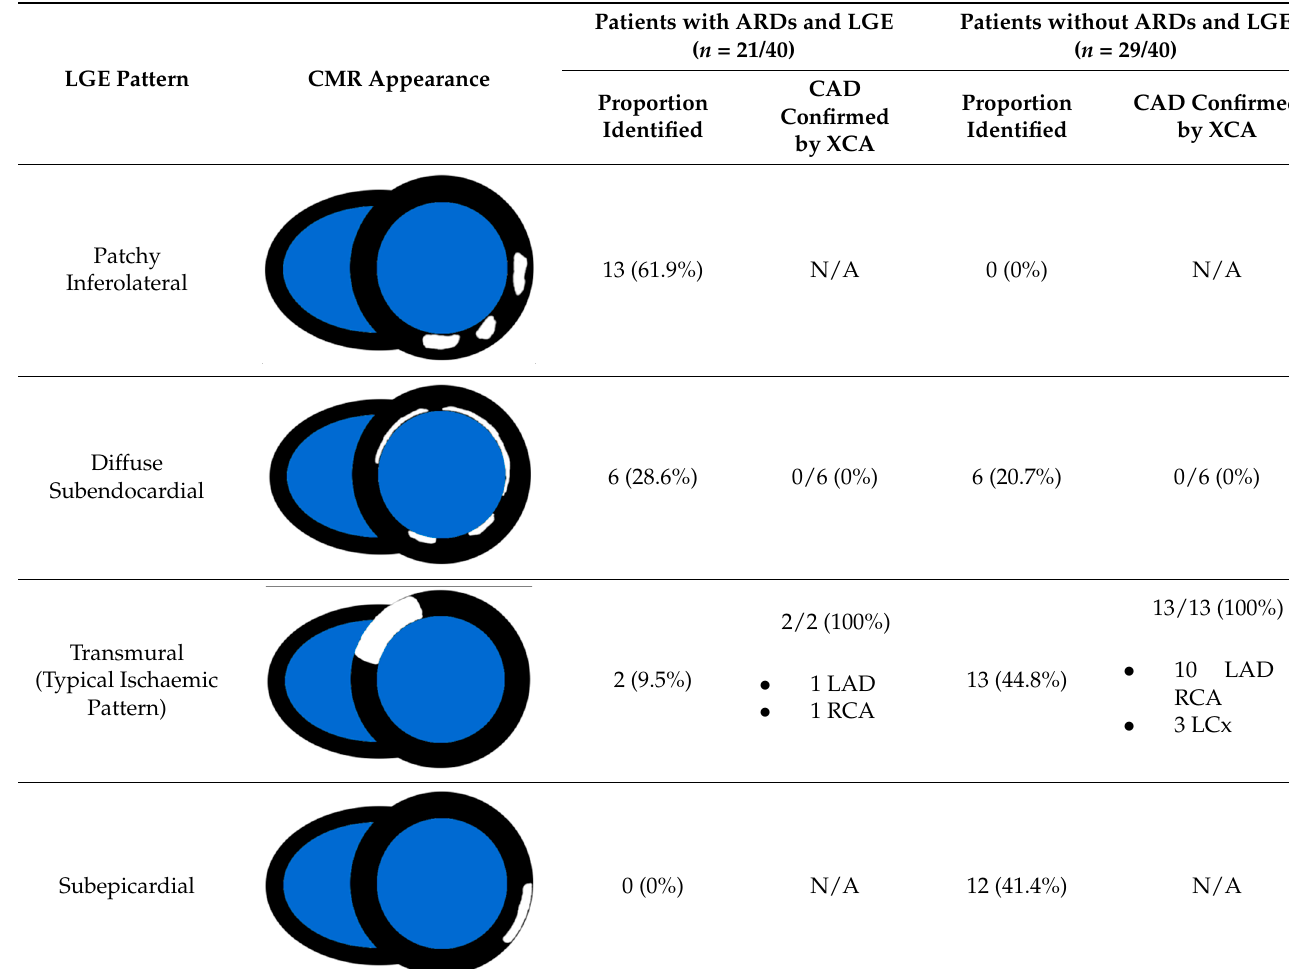
Table 2. Prevalence of different patterns of myocardial fibrosis in patients with LGE with and without ARDs. The proportion of LGE patterns was significantly different between the groups ( p < 0.0001). The vast majority of patients with ARDs and identified myocardial fibrosis on CMR had no evidence of CAD.